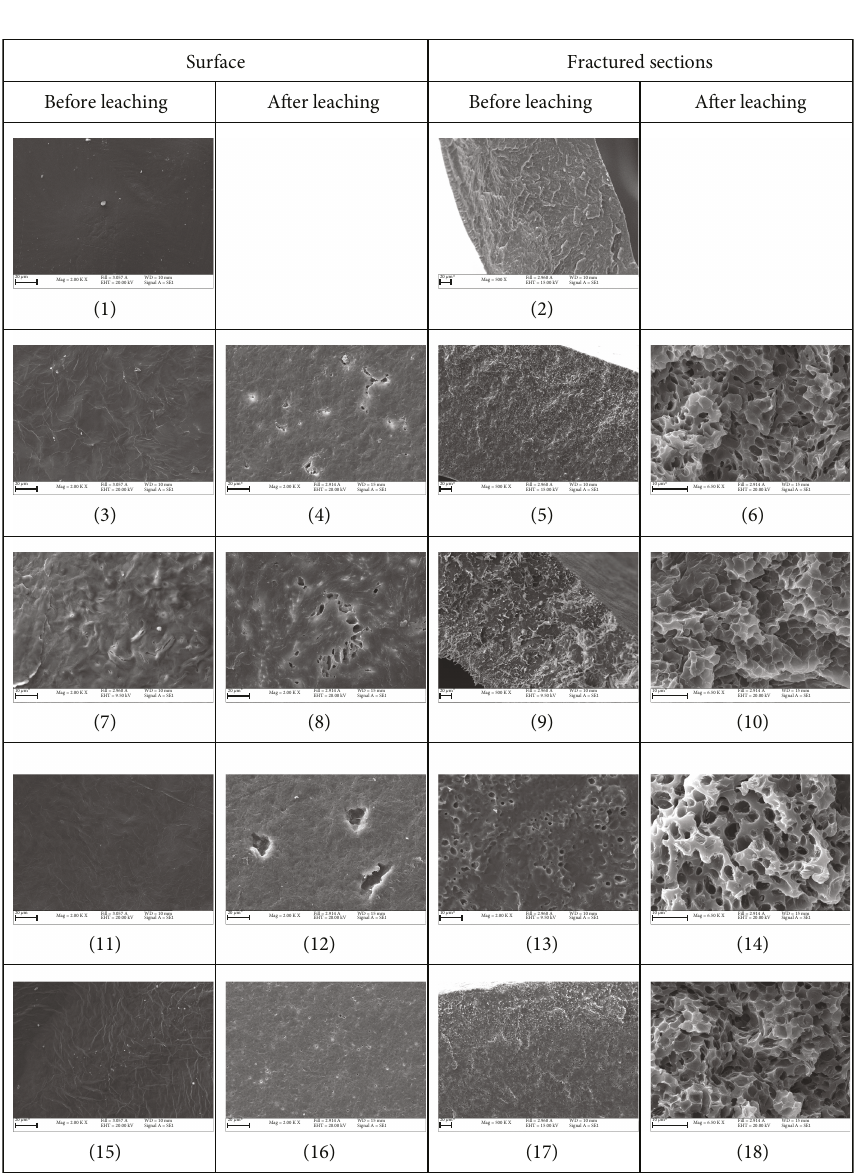
Figure 1: SEM images of the surface and fractured sections of materials before (odd numbers) and after (even numbers) leaching: PCL (1, 2), PCL/PEG1 70/30 (3, 5), PCL7-1i (4, 6), PCL/PEG1 60/40 (7, 9), PCL6-1i (8, 10), PCL/PEG2 70/30 (11, 13), PCL7-2i (12, 14), PCL/PEG2 60/40 (15, 17), and PCL6-2i (16, 18). Scale bar = 20 μ m for surfaces and 10 μ m for section